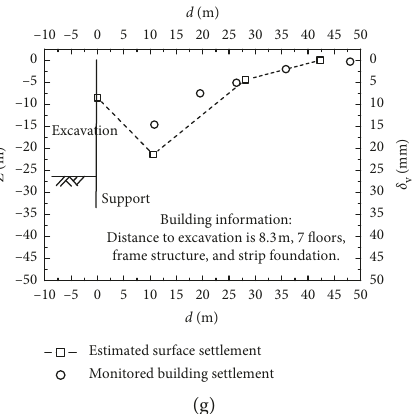
Estimated surface settlement Monitored building settlement (g) Figure 13: Building foundation settlements in zone B: (a) Xiaoshi Uptown Station: Xixia Power Company; (b) Xiaoshi Uptown Station: Xiaoshi Hospital; (c) Yuhua Gate Station: Yuhua Village Residential Building; (d) Fenghuangshan Park Station: Jiaotong Guesthouse; (e)